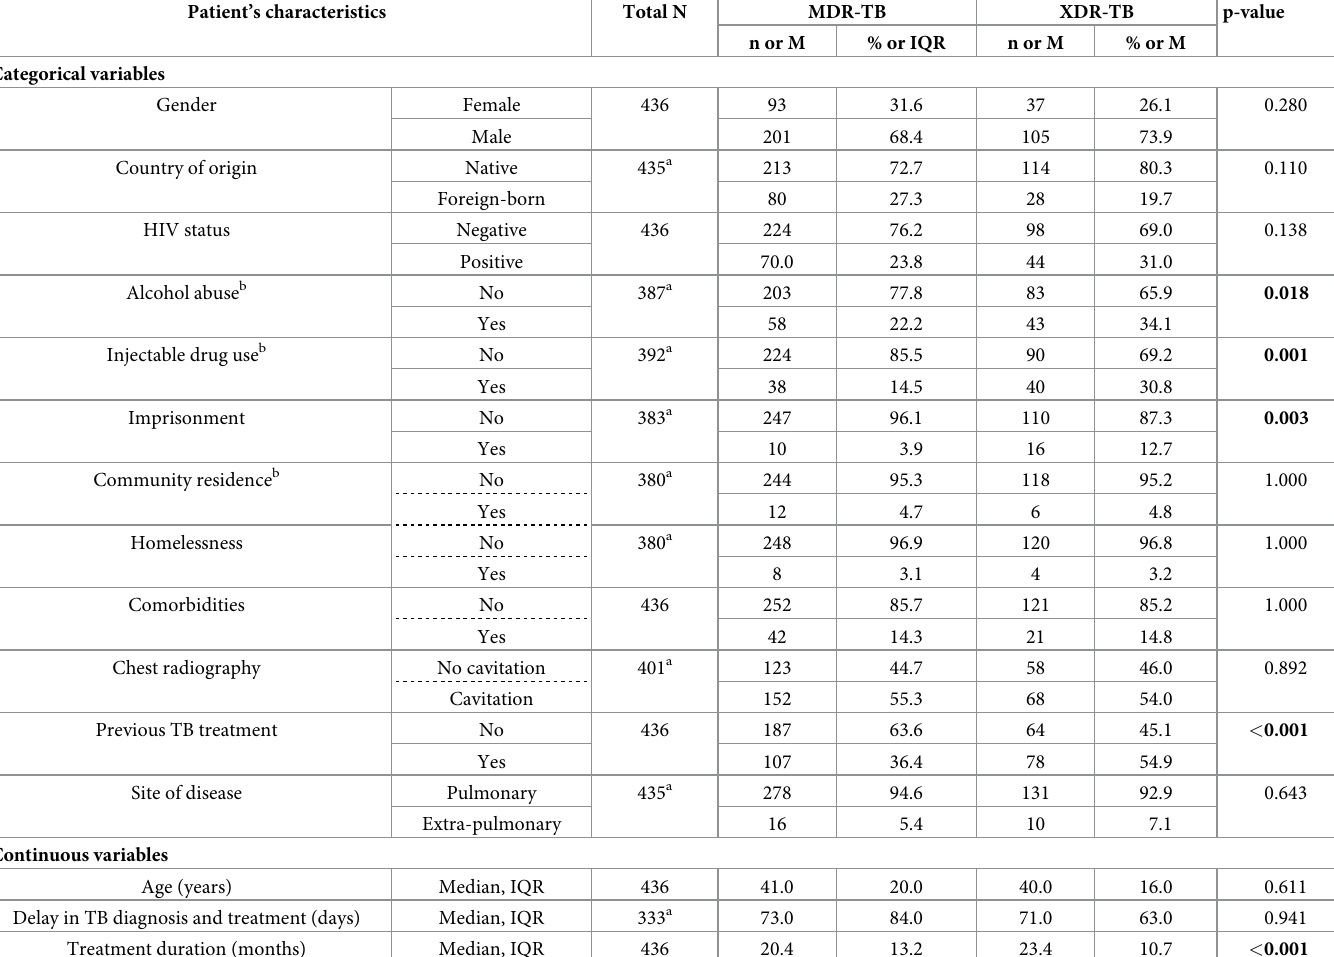
Table 1. Characteristics of multidrug-resistant and extensively drug-resistant tuberculosis patients, considering the cases reported in Portugal between 2000 and 2016 (n = 436). Patient’s